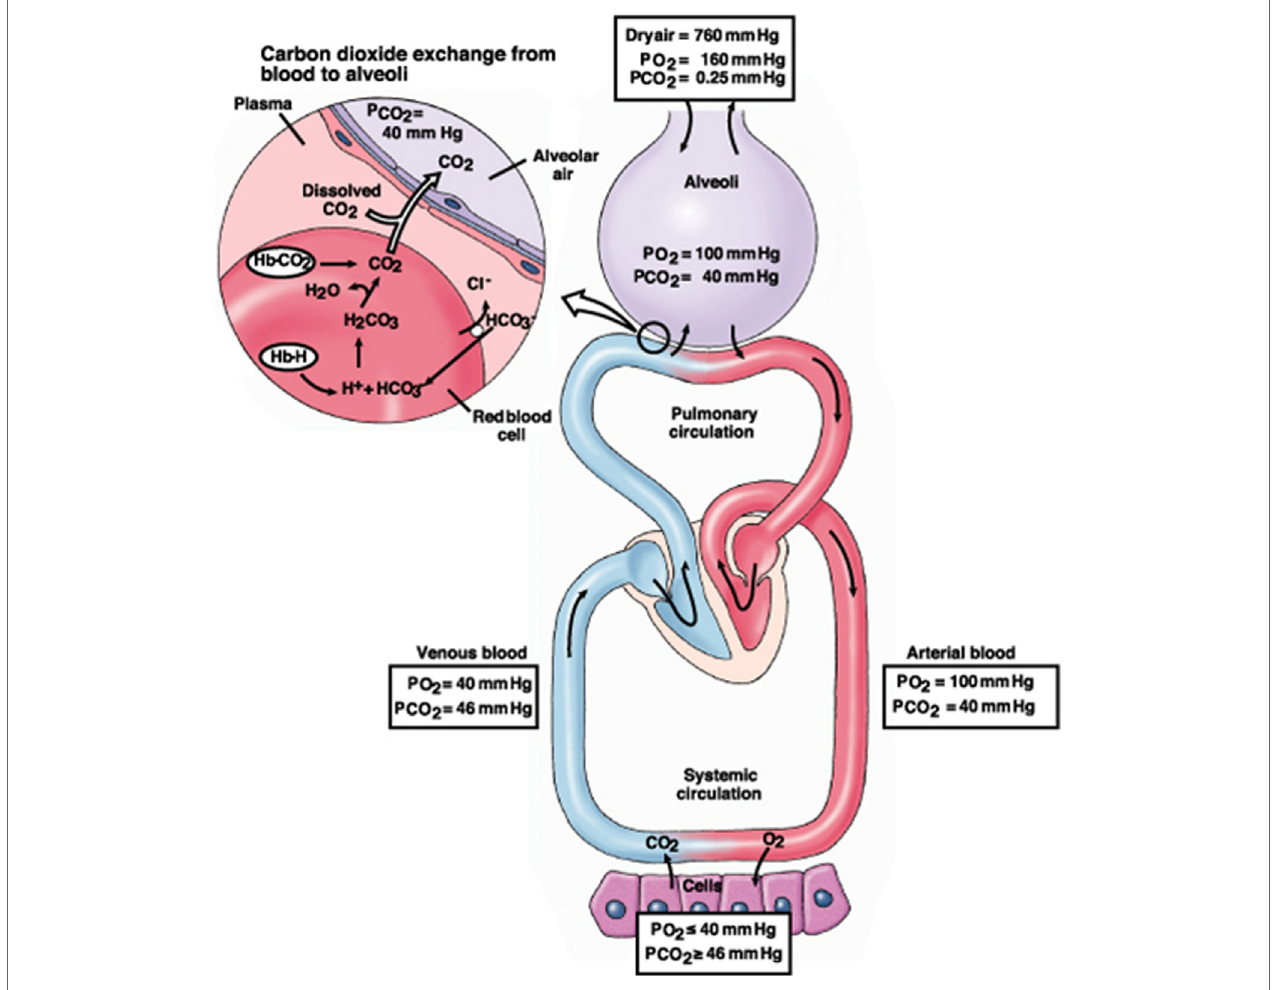
FiGURe 1 | The CO 2 physiology from cells to alveoli.